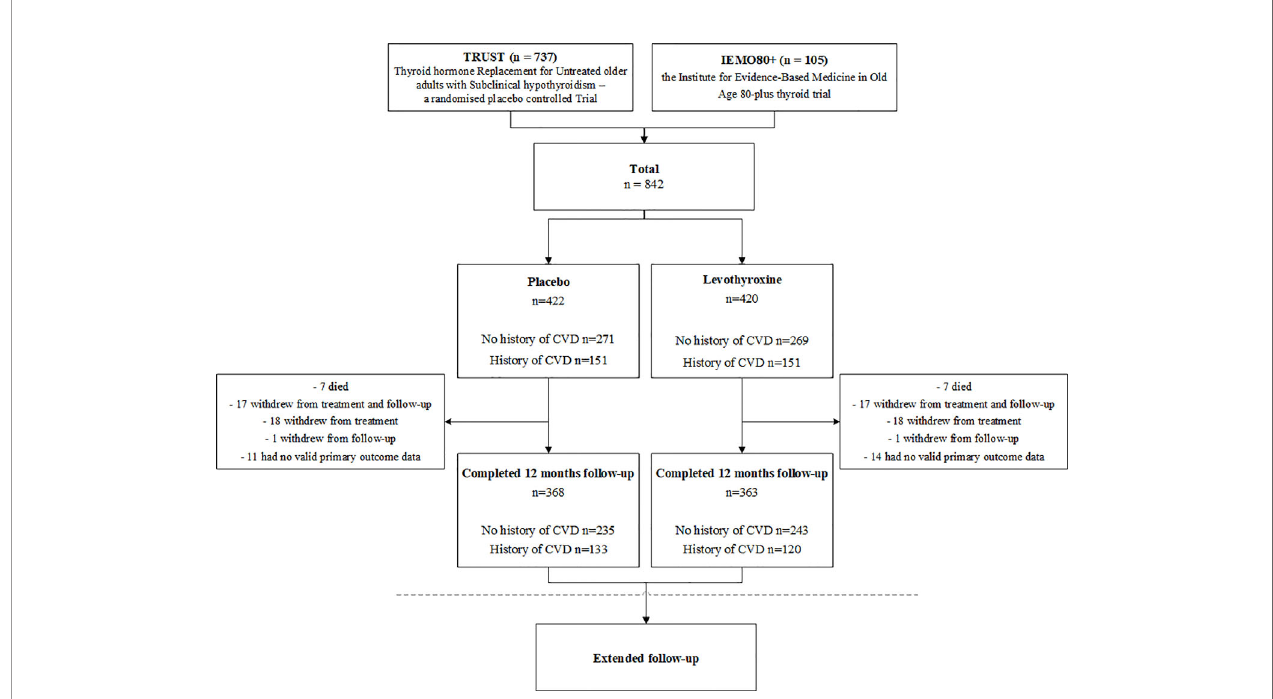
FIGURE 1 | Flowchart study population. Combined data of the TRUST and IEMO80+ trials will be examined as one-stage individual participant data of these two randomised double-blind placebo-controlled parallel group trials. Cardiovascular disease (CVD) is de fi ned as ischemic heart disease, stroke or transient ischemic attack, heart failure, peripheral vascular disease, revascularisation or atrial fi brillation. Median follow-up was